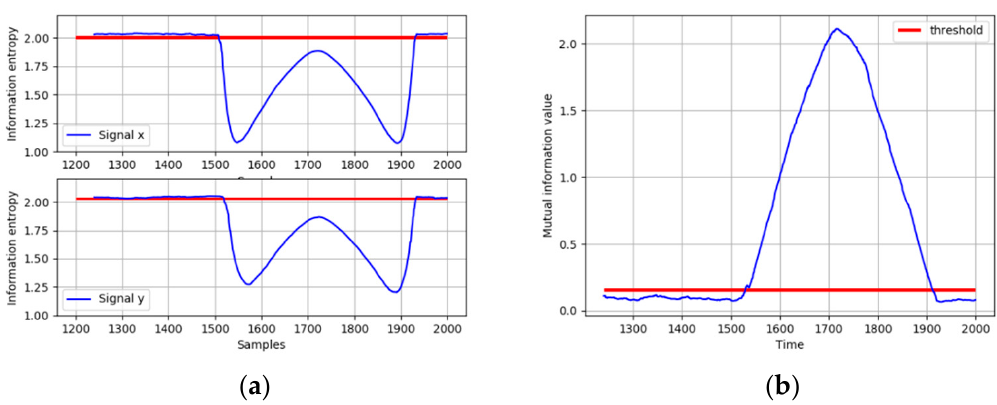
( b ) Figure 6. ( a ) IE calculated under normal conditions; ( b ) distribution of MI under normal conditions. When the ramp fault occurs, the IE of x and y are calculated. As shown in Figure 7a, both the IE of x and y decrease significantly and fall below the thresholds, indicating that the distributions of x and y both deviate from the normal operating condition. In order to diagnose the root cause of this fault, the MI between x and y is calculated and compared with its threshold. It can be seen from Figure 7b that the MI between x and y exceeds its threshold when the fault occurs, which means that the fault could be propagated between x and y . The direction of the interaction between x and y is identified based on the TDMI